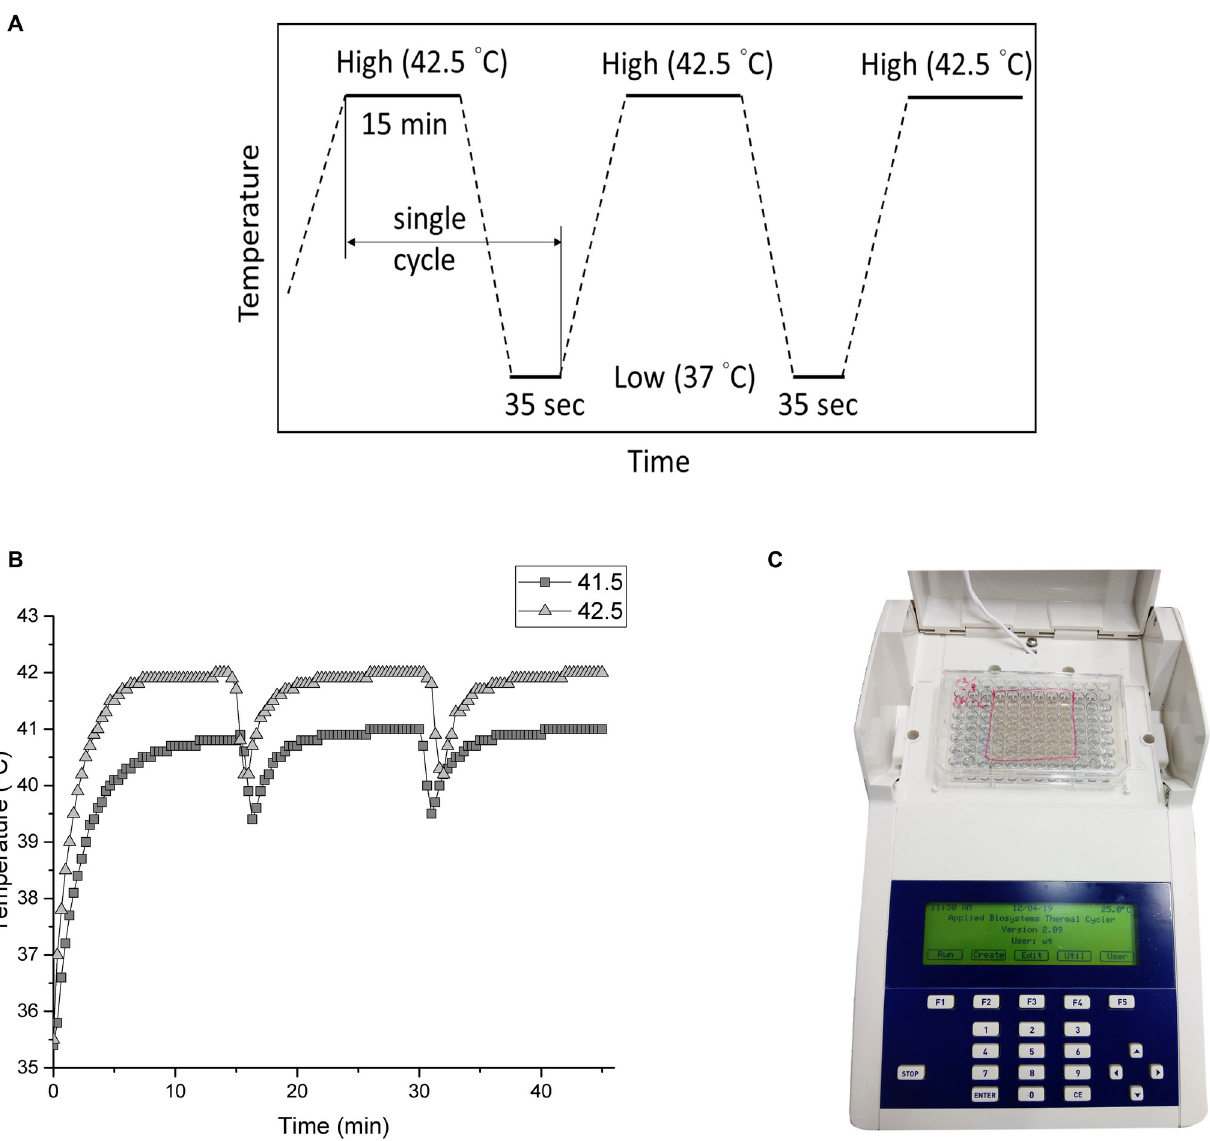
Fig 1. The setup of TC-HT. (A) Schematic representation of TC parameter settings. (B) Measurement of the cell temperature during the TC treatment by the thermocouple. (C) Image of the TC controller setup.